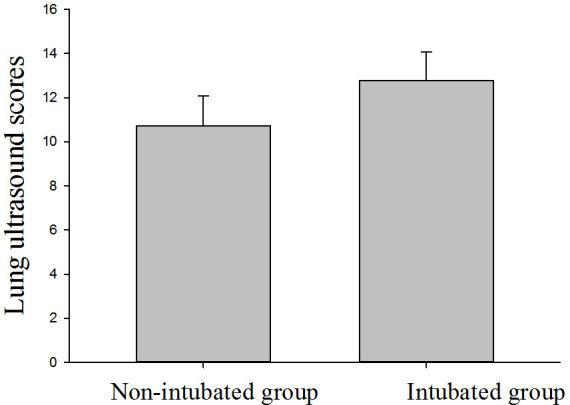
Comparison of lung ultrasound score in the two study groups on T1 (P = 0.05).